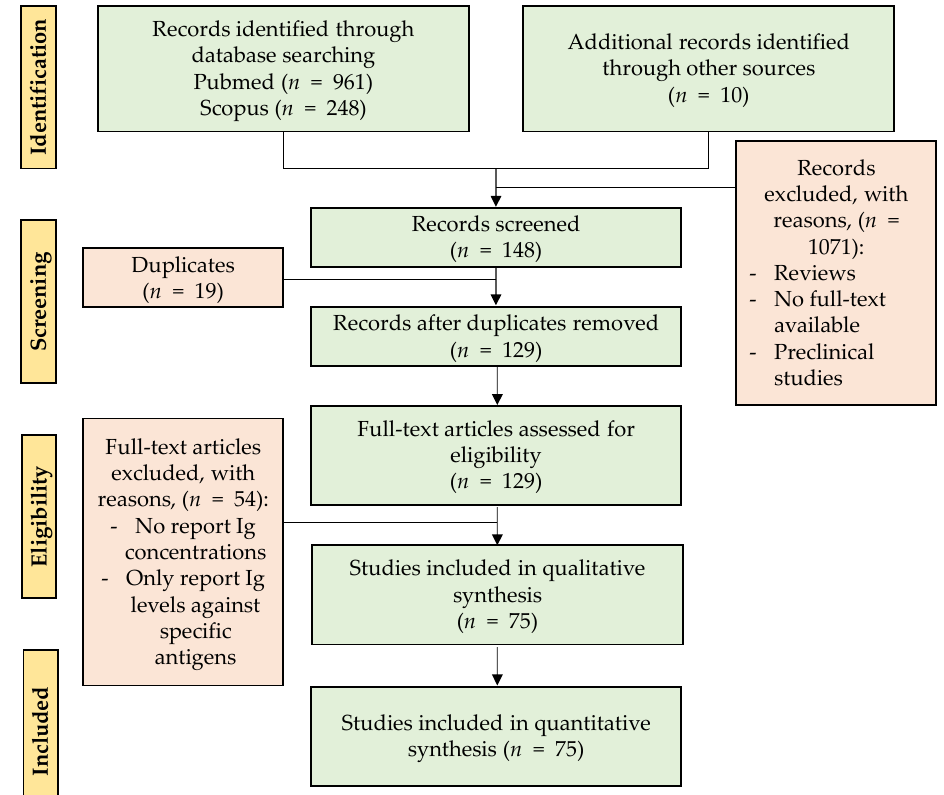
Figure 2. Diagram of the different phases of the search strategy. The flow figure shows the number of articles obtained after the identification and screening steps and those finally used for the review after the eligibility and final inclusion steps. Other sources correspond to the articles related to the topic found in the bibliography of the revised documents.